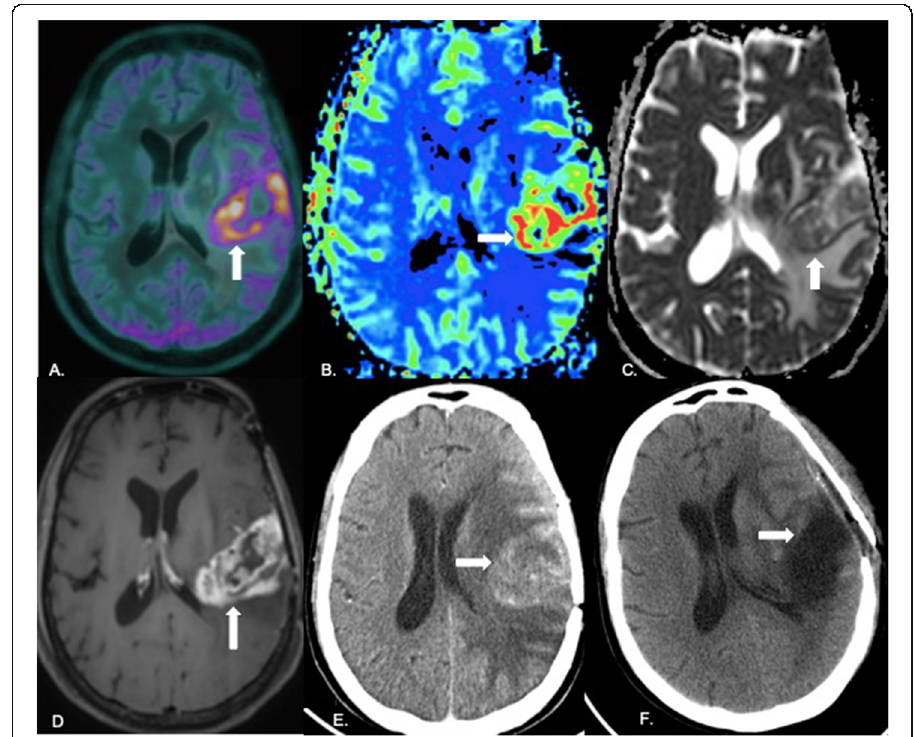
Fig. 5 Concordant PET, perfusion, diffusion and enhancement in a case of recurrence: 40-year-old male diagnosed with anaplastic ODG 15 months back. Underwent surgical excision followed by radiotherapy completed 13 months earlier. PET image overlaid over T1 MPRAGE ( A ) shows a large area of uptake in the left temporoparietal region (white arrow). rCBV map ( B ) generated with the leakage correction algorithm shows elevated perfusion in the same region (white arrow) with diffusion restriction on the ADC map (white arrow in C ). Note enhancement on the post-contrast image (white arrow in D ). In view of unequivocal evidence of recurrence, surgery was planned. Post-contrast axial CT brain acquired prior to surgery ( E ) shows an enhancing left parietal lesion (white arrow). Post-operative plain axial CT brain (F) shows the resection cavity (white arrow) with gross total excision. Histopathology revealed recurrent GBM. This is a case of recurrence where the PET, perfusion, diffusion, and contrast images were concordant with good spatial